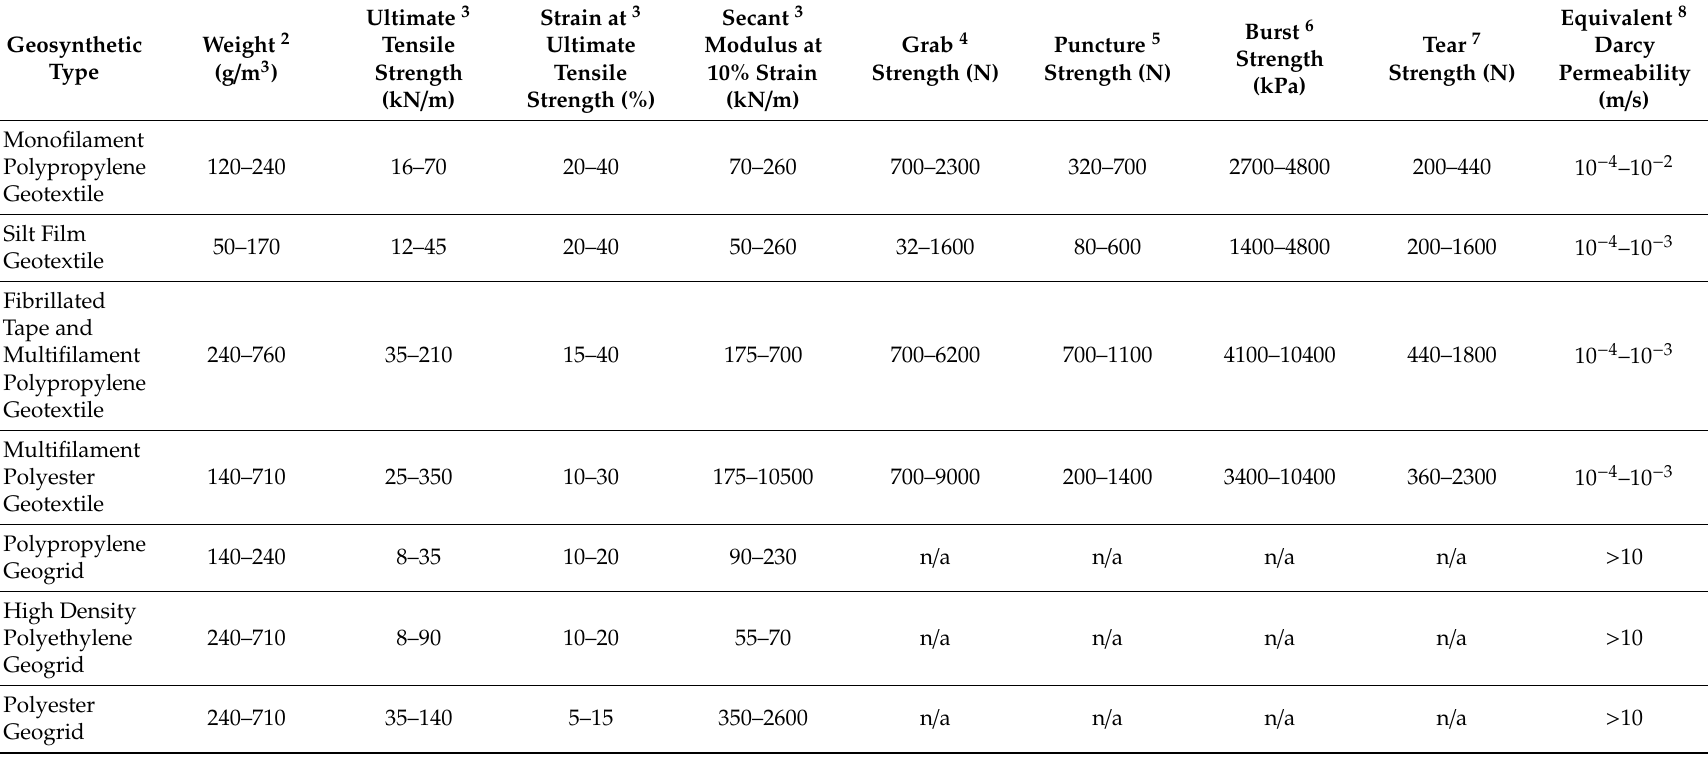
Table 2. Geosynthetic Types, Properties, and Test Methods *